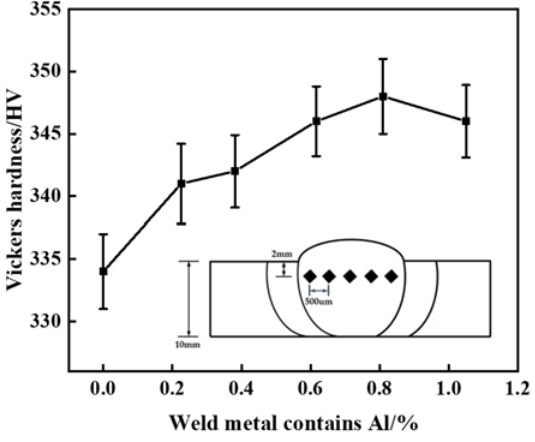
Figure 6. Effect of Al content on Vickers hardness of weld metal.